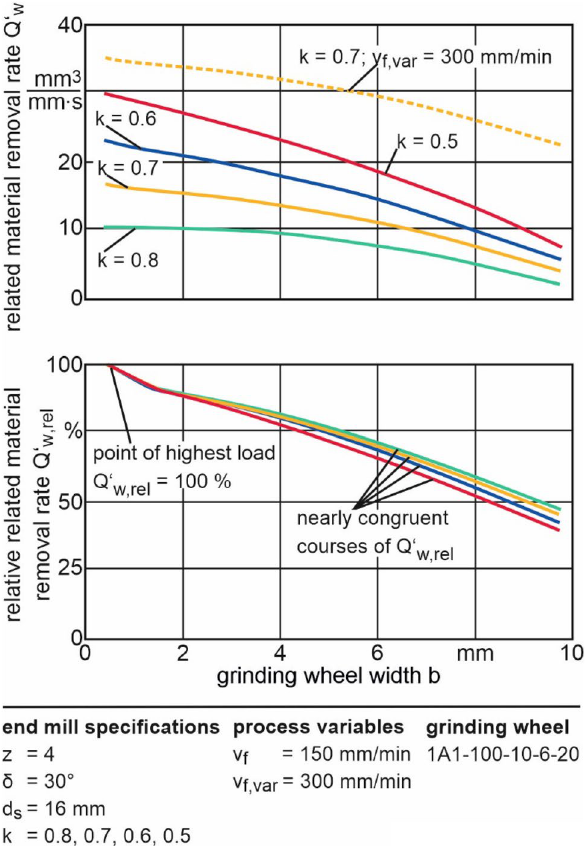
Fig. 3 Simulated related material removal rate for flute grinding of end mill cutters and the calculated relative